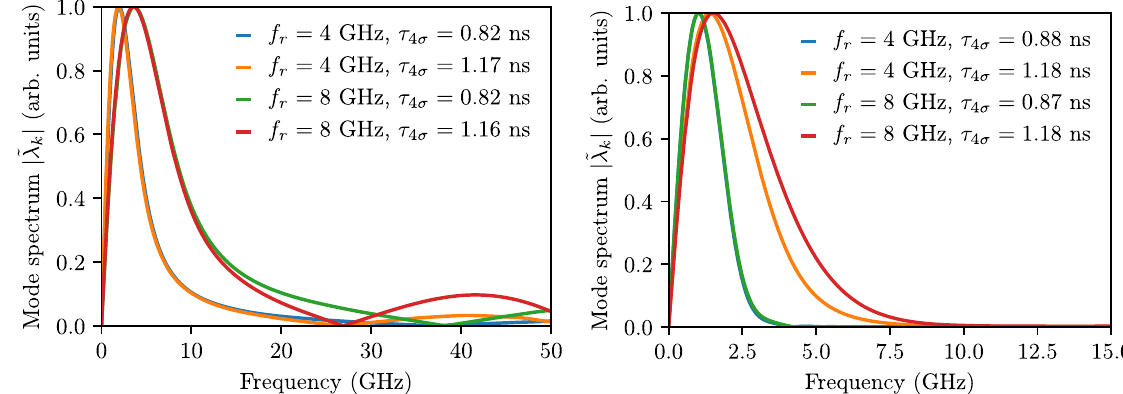
FIG. 11. Coherent mode spectra at the LLD threshold (left) and well above it (right) found using MELODY for different values of resonator frequency f and bunch length τ 4 σ for a broadband resonator impedance with Im Z=k ¼ 0 . 07 Ω and Q ¼ 1 ; η > 0 , r V 0 ¼ 6 MV and μ ¼ 2 .